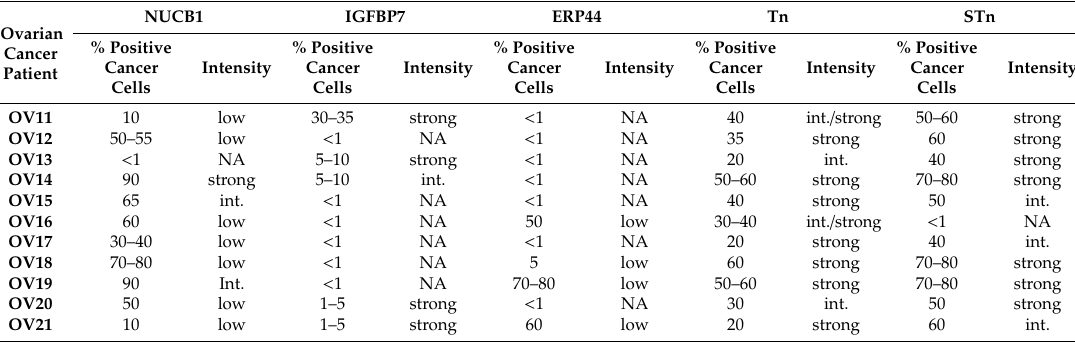
Table 1. Expression of ovarian tumor glycoproteins binders of MGL.